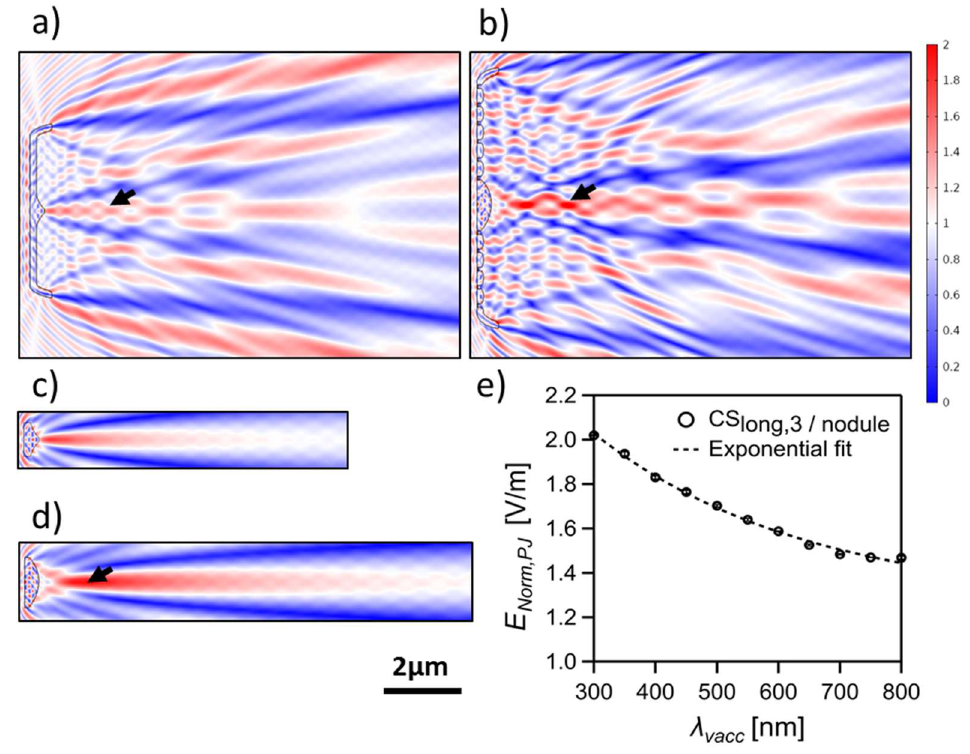
Figure 8. PJ generation in CS ver,2 ( a ) and CS long,3 ( b ) compared to the disassembled nodule zone CS ver,2/nodule ( c ) and CS long,3 /nodule ( d ) at λ vacc 350 nm in the air. ( e ) The plot shows the λ vacc dependency of E Norm,PJ of the PJ generated by CS long,3 /nodule indicated by the black arrow in ( d ).